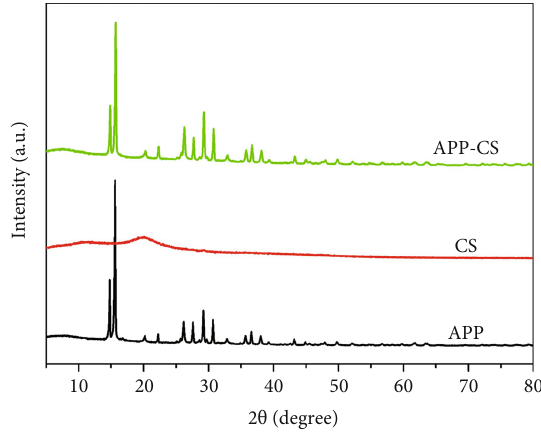
Figure 4: XRD patterns of APP, CS, and APP-CS.